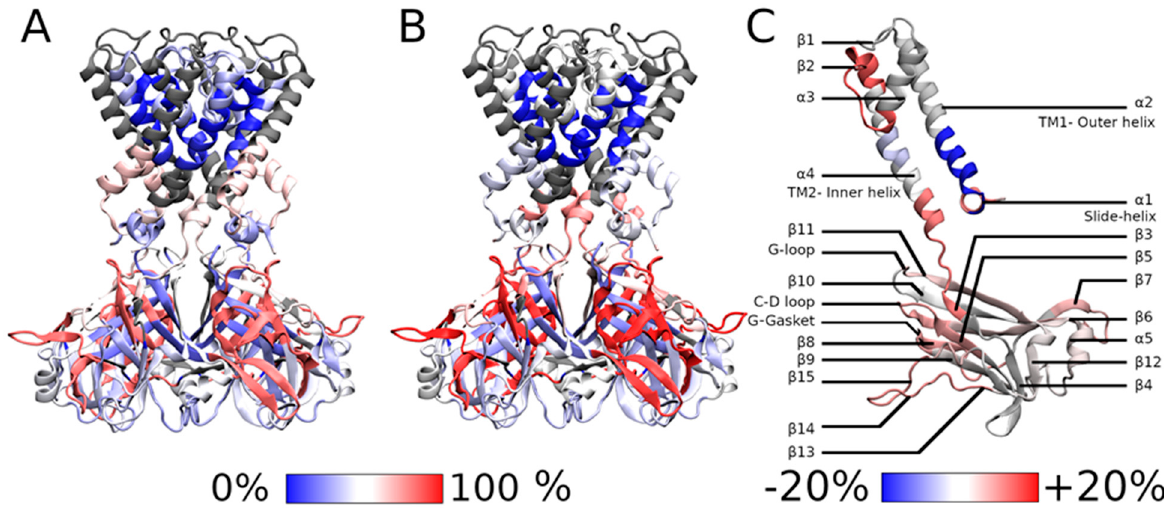
Figure 2. HDX-MS rates. ( A ) HDX-MS rates of peptides that we have reported for the KirBac3.1 WT [18] and ( B ) for the mutant W46R. ( C ) Rate difference between the W46R mutant and KirBac3.1 WT. The scale of the deuterium exchange rate is shown at the bottom of the figures, with blue corre- sponding to low exchange rate and high rigidity; and red to high exchange rate and high flexibility. Our data show that the most flexible regions for KirBac3.1 W46R are the loops ex- tending outside the CTD (aa 271-285 between β 14 et β 15, in red in Figure 2B, see Figure 2C for the nomenclature) with an HDX rate of 68.0%. The next, more flexible, three domains are: (i) at the G-gasket just below the CD-loop and the entire β 8, (aa 199–210, with HDX rate of 66.0%); (ii) the stretch going from the end of the β 5 and the start of the β 6 including the CD-loop in the middle (aa 162–174, HDX rate of 65.7%); and (iii) the stretch going from the end of β 6 and the start of β 7 including the facing-down loop in the middle (aa 181–194, with HDX rate of 64.1%). On the CTD, the stretch including the end of the G-